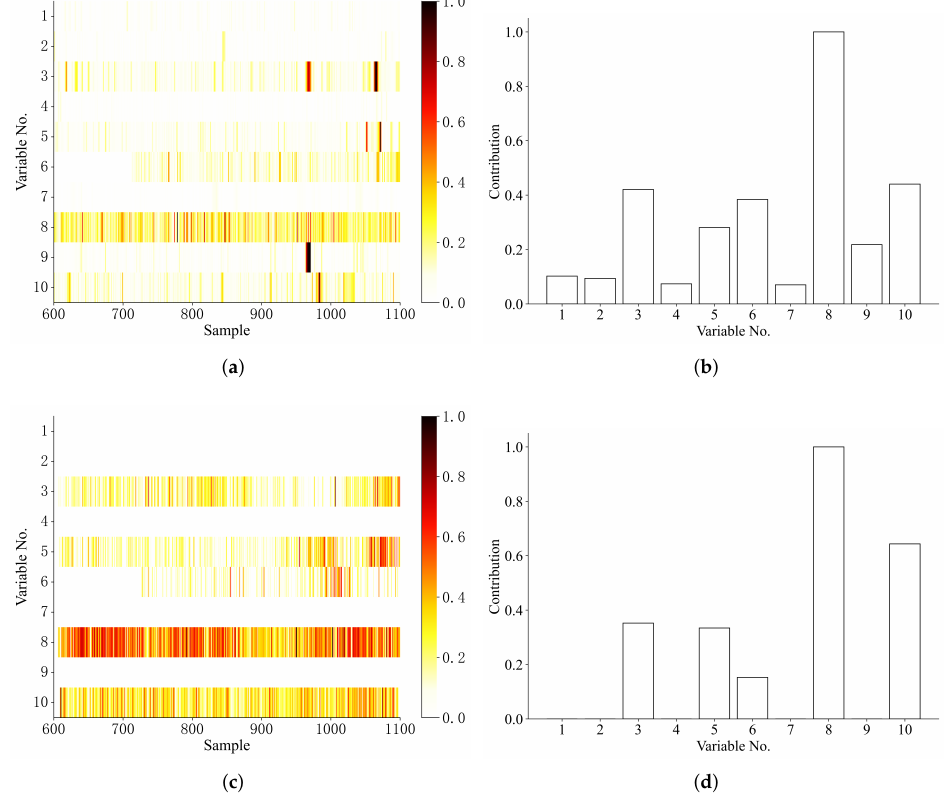
Figure 7. Fault isolation results for the boiler over-temperature process ( a ) BRNN with LDR isolation ( b ) BRNN with LDR contribution ( c ) Wasserstein distance isolation ( d ) Wasserstein distance